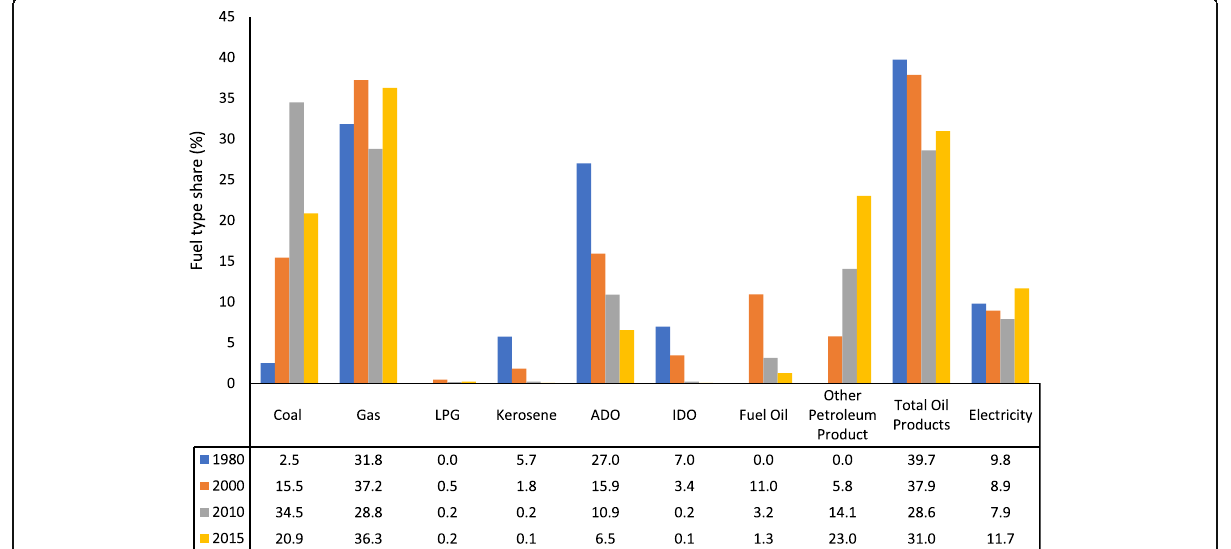
Fig. 1 Total final energy consumption by fuel in